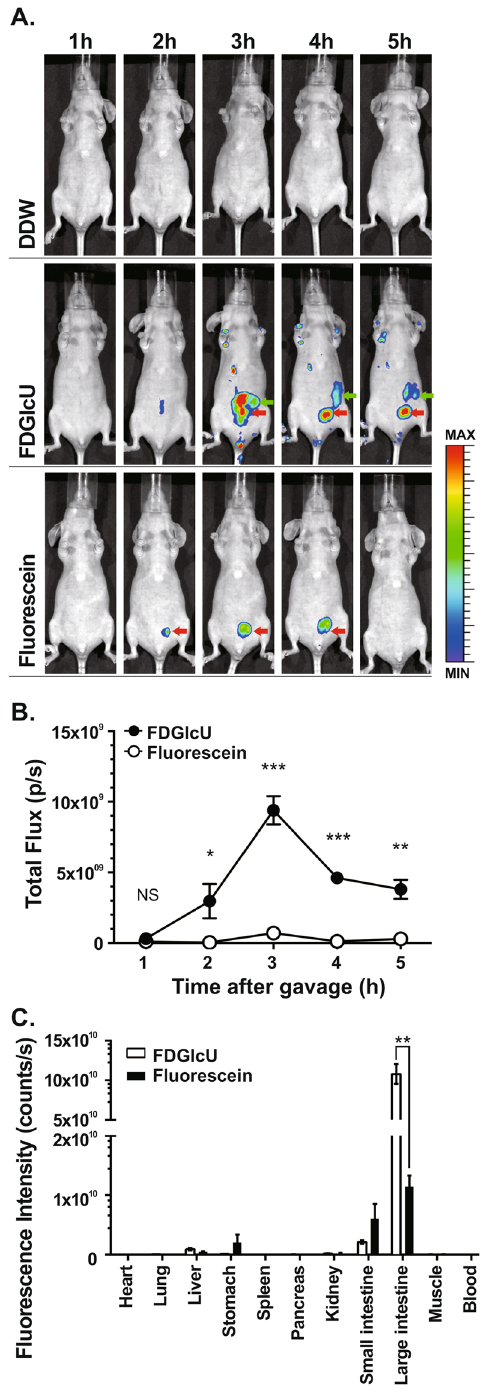
Figure 2. In vivo optical imaging of β G activity by FDGlcU. ( A ) Serial whole-body images at indicated time points after oral gavage with DDW (top), FDGlcU (middle), and fluorescein (bottom). Green arrows indicate intestine and red arrows indicate bladder. ( B ) Total flux in abdomens of mice gavaged with FDGlcU ( ● ) (n = 5) or fluorescein ( ○ ) (n = 5). ( C ) The regions of interest in different organs and tissues after oral administration of FDGlcU (n = 3) or fluorescein (n = 3) for 3 hours were analyzed with Living Image software. Error bars indicate SEM. NS, no significant difference. * P value < 0.05. ** P value < 0.01. *** P value <